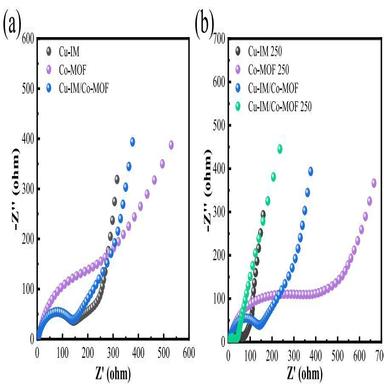
EIS spectra of (a) Cu-IM, Co-MOF, Cu-IM/Co-MOF, (b) Cu-IM 250, Co-MOF 250, Cu-IM/Co-MOF, and Cu-IM/Co-MOF 250 electrodes.